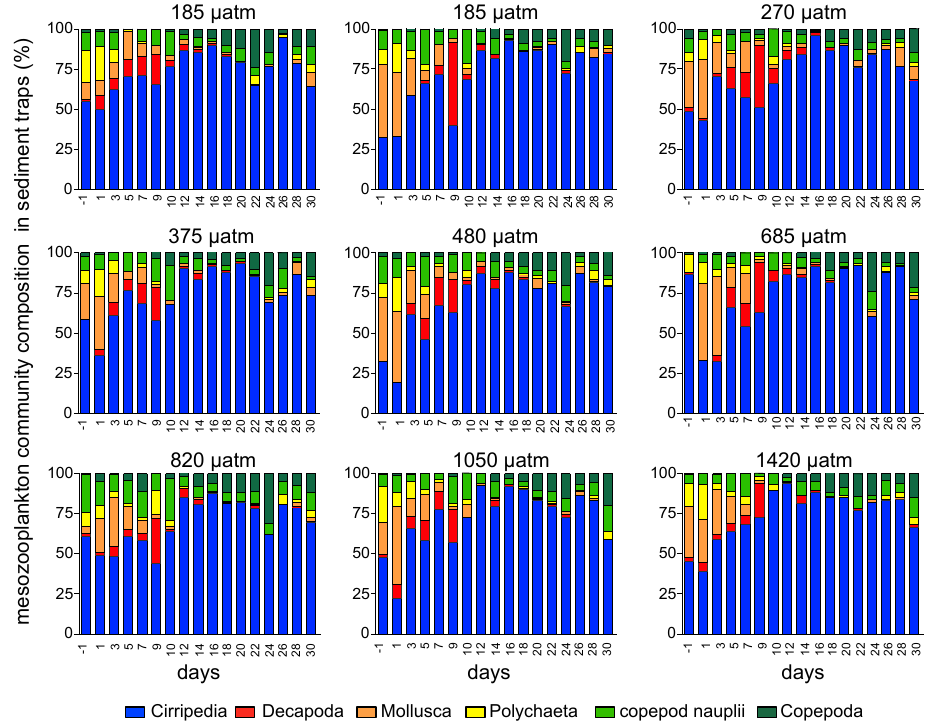
Fig. 4. Mesozooplankton community composition (%) in the sediment traps of the mesocosms: numbers on top of the panels present the initial CO 2 concentration in each mesocosm after the CO 2 manipulation was completed. Please, note that “Copepoda” includes copepodites and adults; copepod nauplii are presented as a different group.